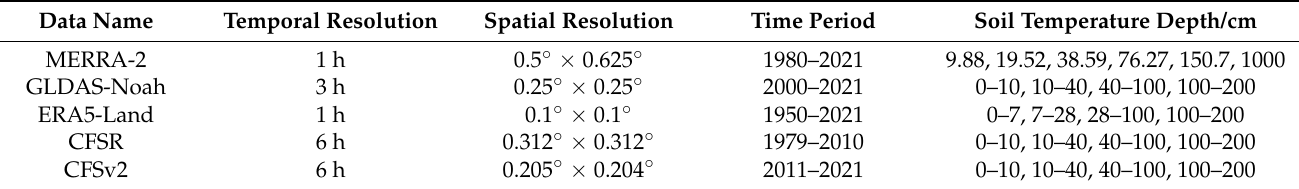
Table 2. Description of reanalysis